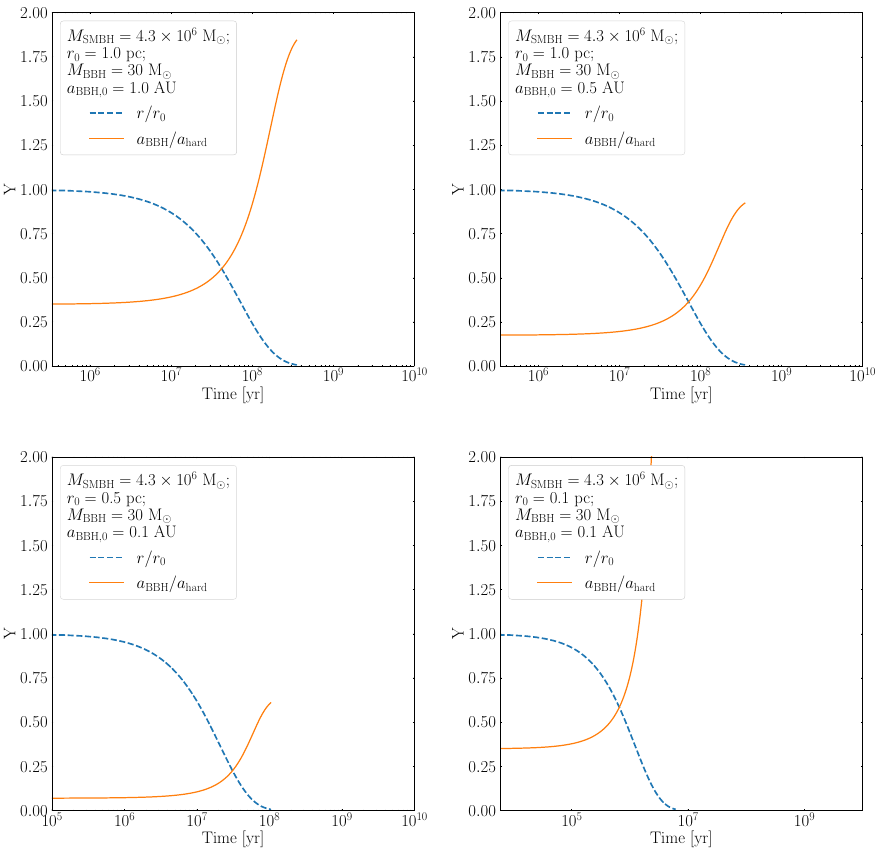
Figure 6. Time evolution of the BBH semimajor axis normalised to the local hard binary separation (orange straight line) and the BBH position within the cluster normalised to the initial position (blue dashed line). We assumed an SMBH with mass M SMBH = 4.3 M BBH = 30 M (cid:12)